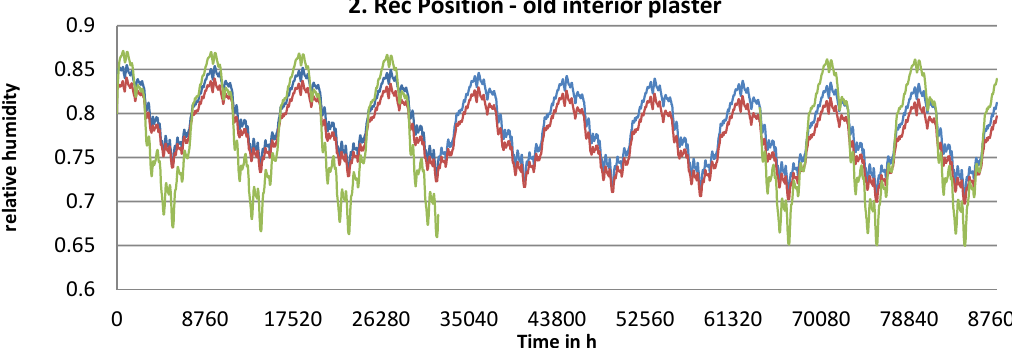
Figure 4. Relative humidity at Rec Position 2, in old interior plaster; (blue) MiWo, (red) Sheep wool and (green)